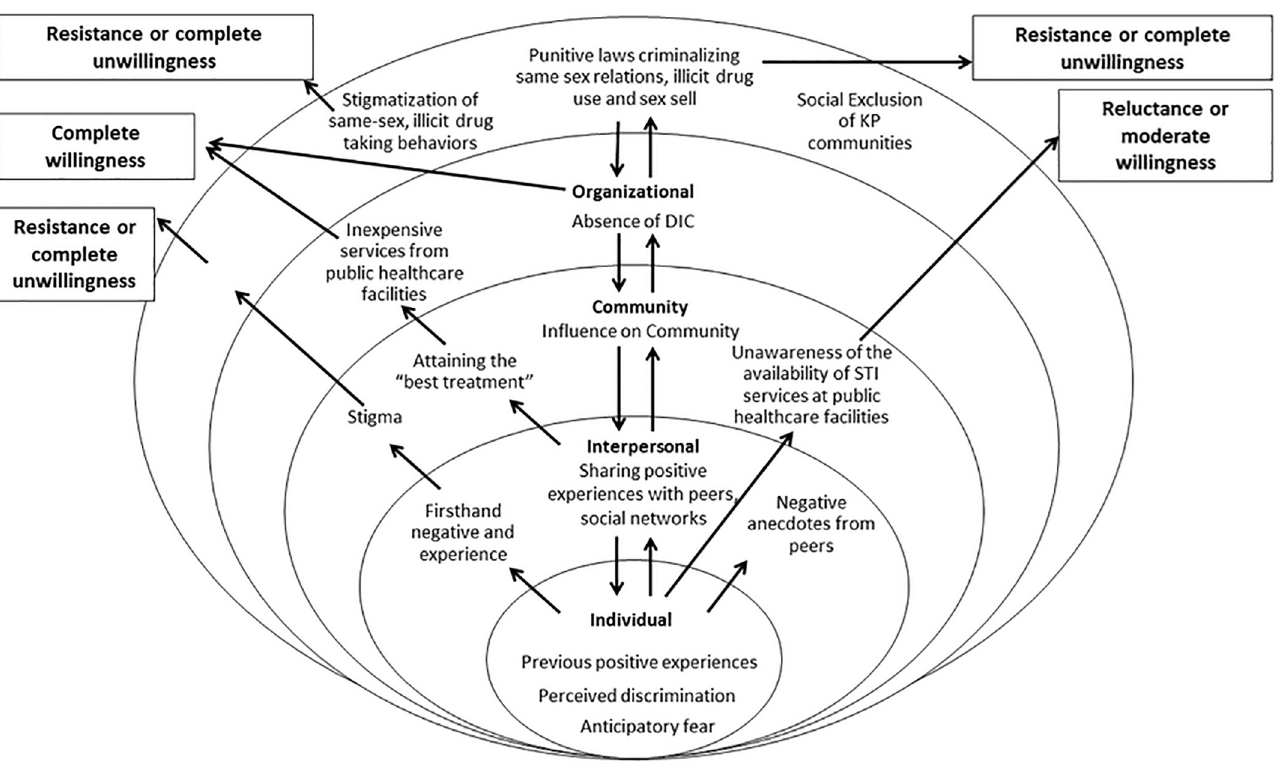
Fig 1. SEM framework on community